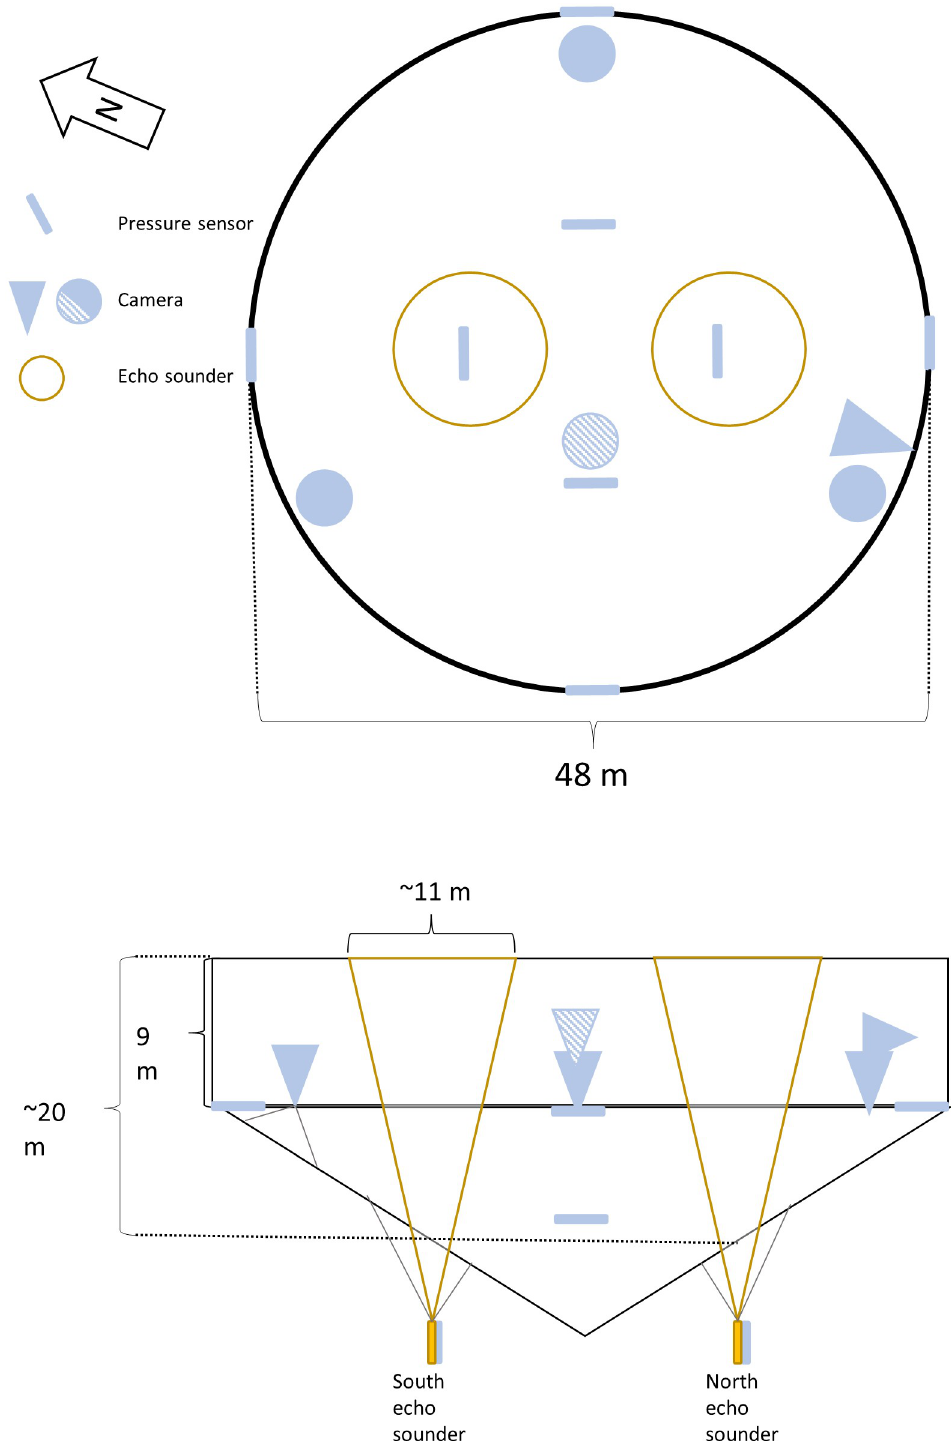
Fig 2. Layout of equipment. Aerial and side on view of the study cage with the location of echo sounders (yellow circles and cones show viewing area of echo sounders), pressure sensors (attached to the net and shown as blue bars) and video cameras (shown as circles or cones depending on viewing angle). Camera viewing angles are approximate. The camera with diagonal stripes is the feed camera, which was nearer the surface than the bottom mounted cameras.